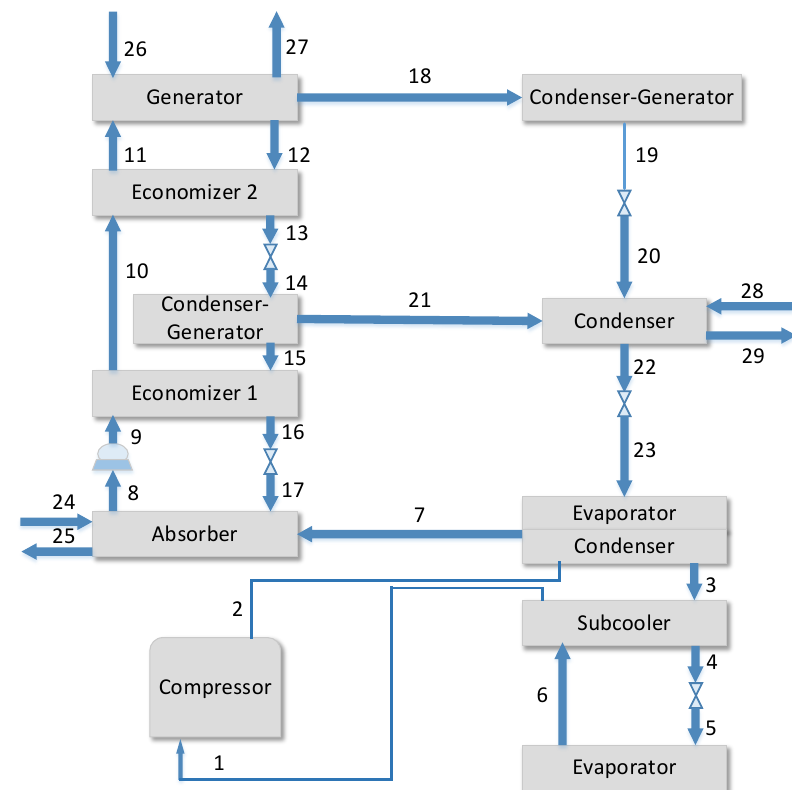
Figure 6. Schematic diagram of compression–absorption double-stage (CADS) system [66]. Reproduced with permission from [Elsevier], Elsevier, 2020.